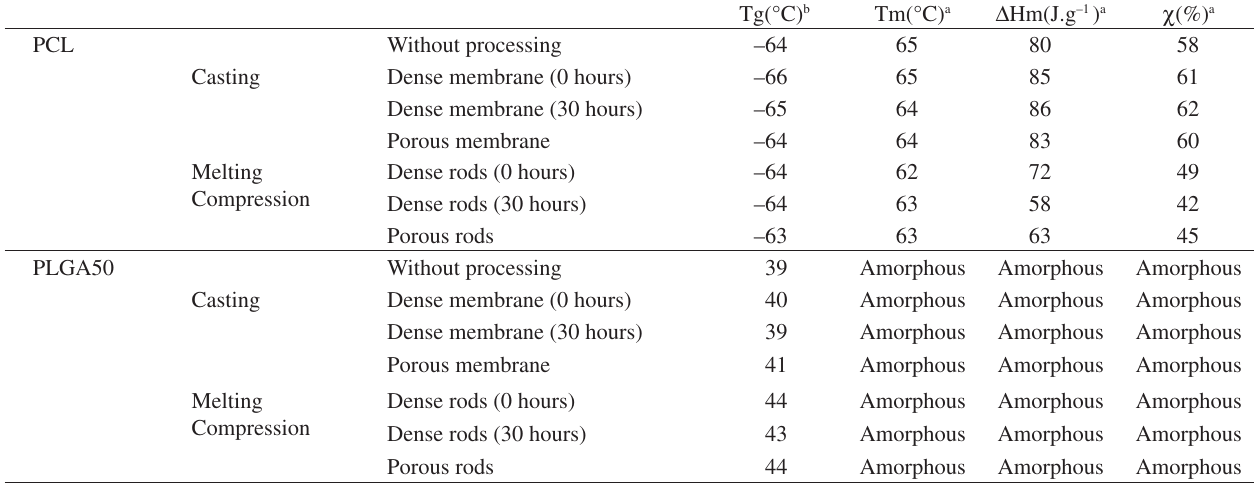
Table 1. Differential scanning calorimetric data for PCL and PLGA50 samples, without processing, before and after (30 hours) immersion in distilled water. (Tg) glass transition, (Tm) melting temperatures, ( ∆ Hm) melting enthalpies, ( χ ) degree of